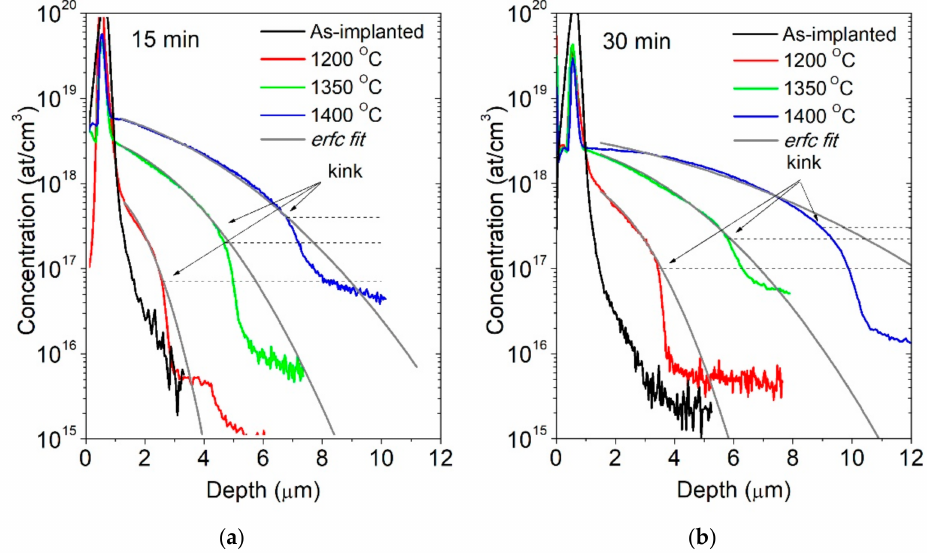
Figure 6. Results of SIMS measurements. Be depth profiles for samples as-implanted and annealed in the temperature range 1200 ◦ C–1400 ◦ C for: ( a ) 15 min; examples of the kink are marked, ( b ) 30 min; gray curves are error function (erfc) function fitting; black dotted lines indicate the concentration level of the kink in the